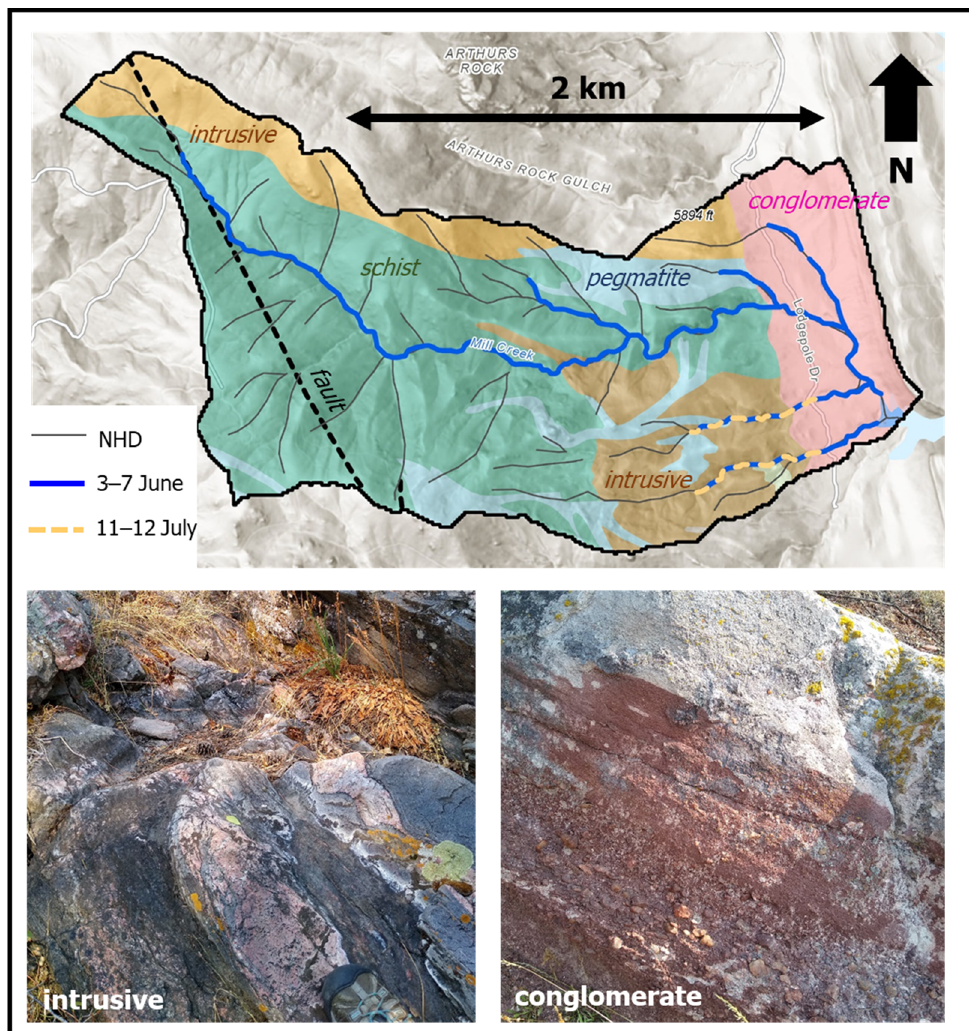
Figure 2. Mill Creek National Hydrography Dataset High Resolution (NHD HR) flowlines and field-mapped streamflow locations over a hillshade and a digitized geologic map adapted from [52]. Blue lines indicate the surface flow locations for the first field survey, and dashed orange lines overlaying the blue lines indicate the surface flow locations for the second survey. The images are examples of bedrock outcrops within the catchment.